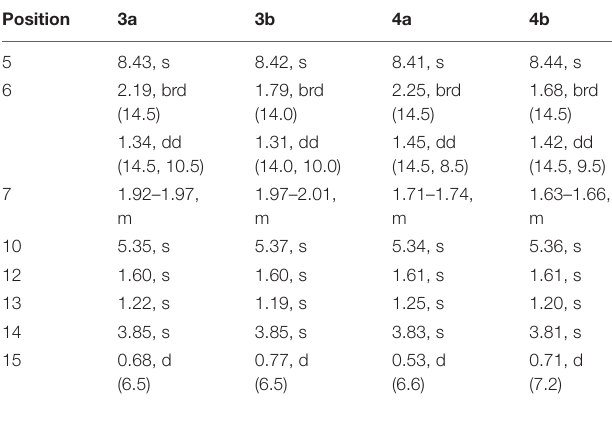
TABLE 4 | IC 50 and MIC values of 7 against phytopathogenic bacterial